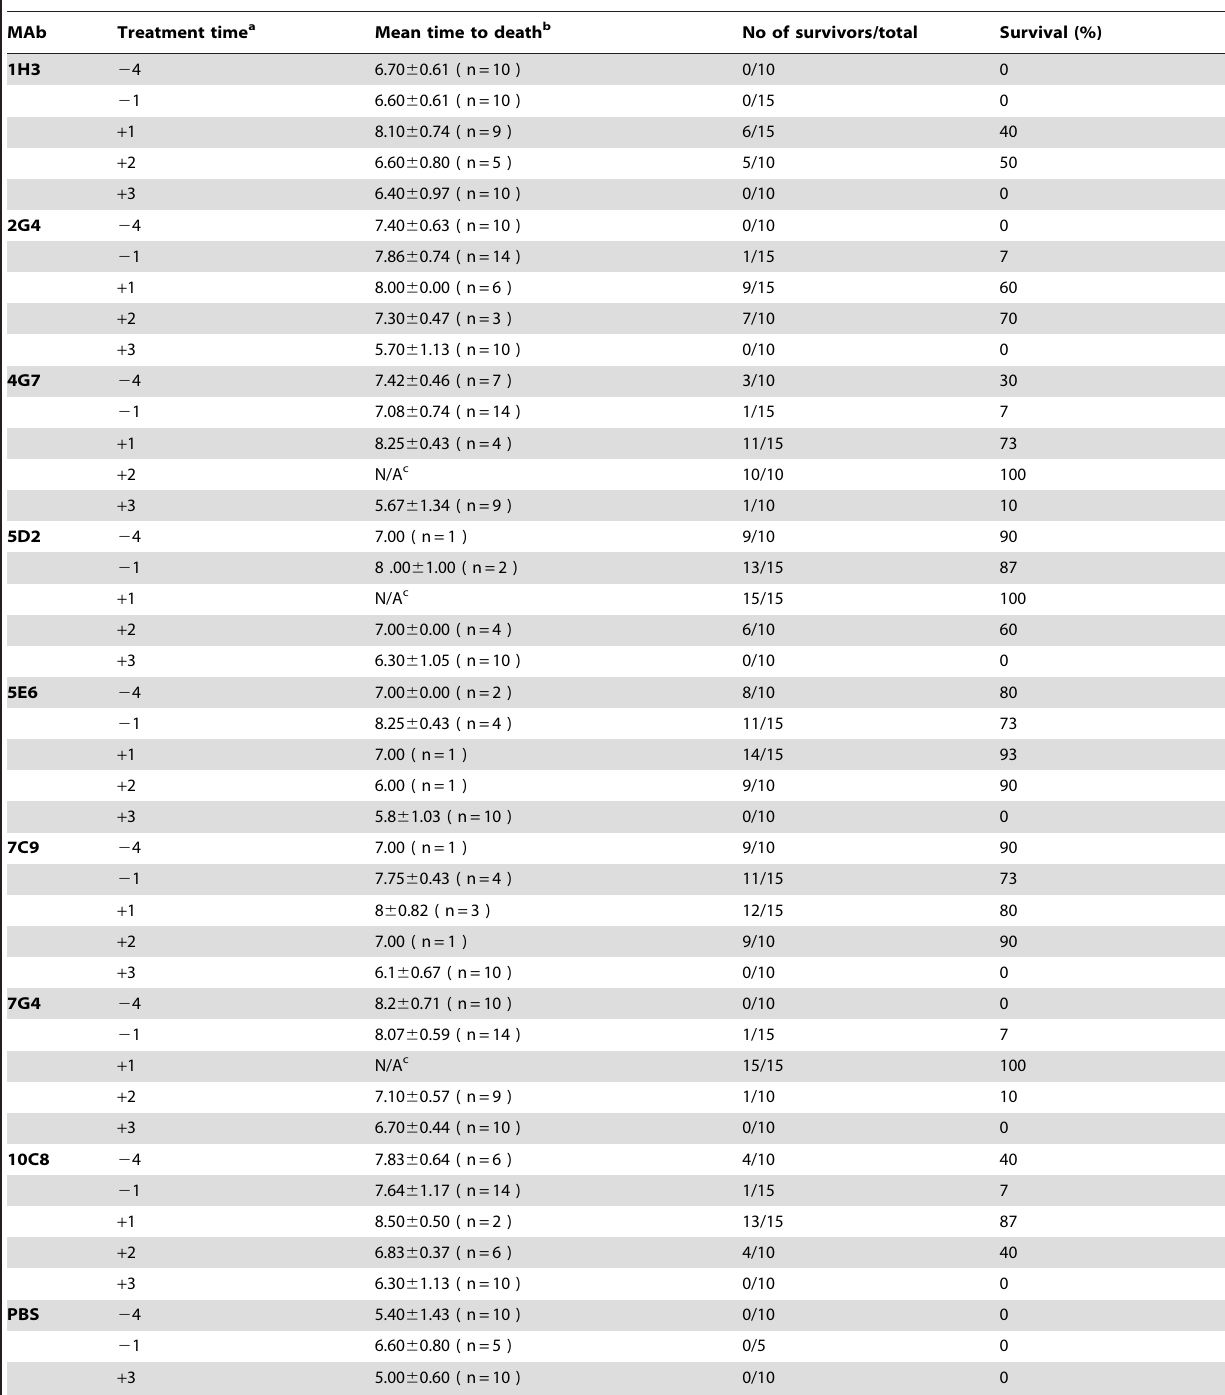
Table 3. Time-dependent protective efficacy of MAbs in mice.